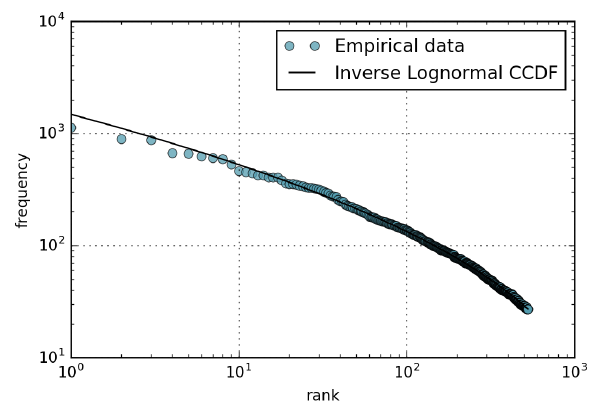
Figure 6. Rank-frequency plot of the 1000 most popular Wikipedia pages in February 2016.